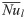
Effect of Ra and α on Nu¯l for the two selected porous matrixes in the case A = 0.5.